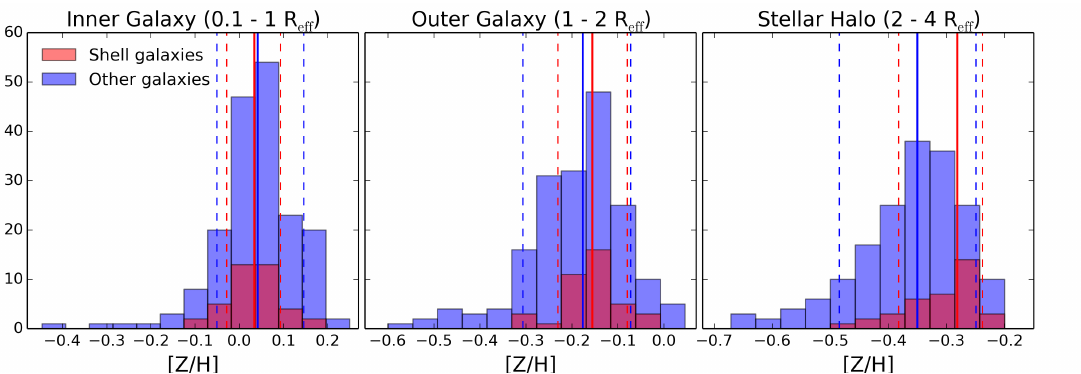
Figure 5. Histograms of the average logarithmic metallicities of stars in a sample of 220 massive elliptical galaxies. The shell galaxies identified in P17 are shown in red, with the other galaxies in the sample shown in blue. We measure [Z/H] within three radial ranges, based on the effective radius of each galaxy, R eff , defined as the radius that contains half of the total light. The median [Z/H] for all shell/non-shell galaxies is marked by a continuous line, while dashed lines mark the 10% and 90% percentiles. The average total stellar metallicities are similar for shell and non-shell galaxies at galactocentric distances < 2R eff . In the extended stellar halo, we find that shell galaxies in our sample have higher average metallicities (shallower metallicity gradients) than galaxies without